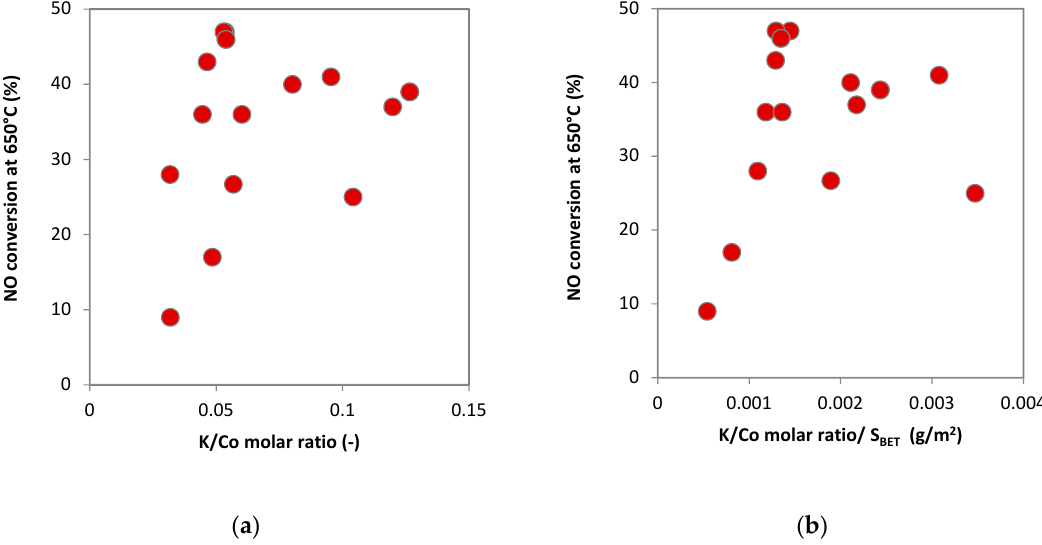
Figure 16. Dependence of NO conversion on: ( a ) real K/Co molar ratio and ( b ) K/Co molar ratio to specific surface area.